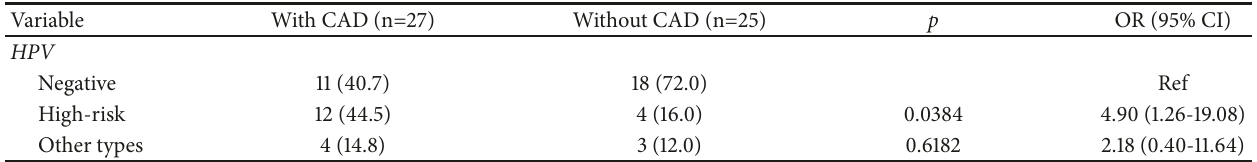
Table 3: Association between HPV infection and the occurrence of CAD